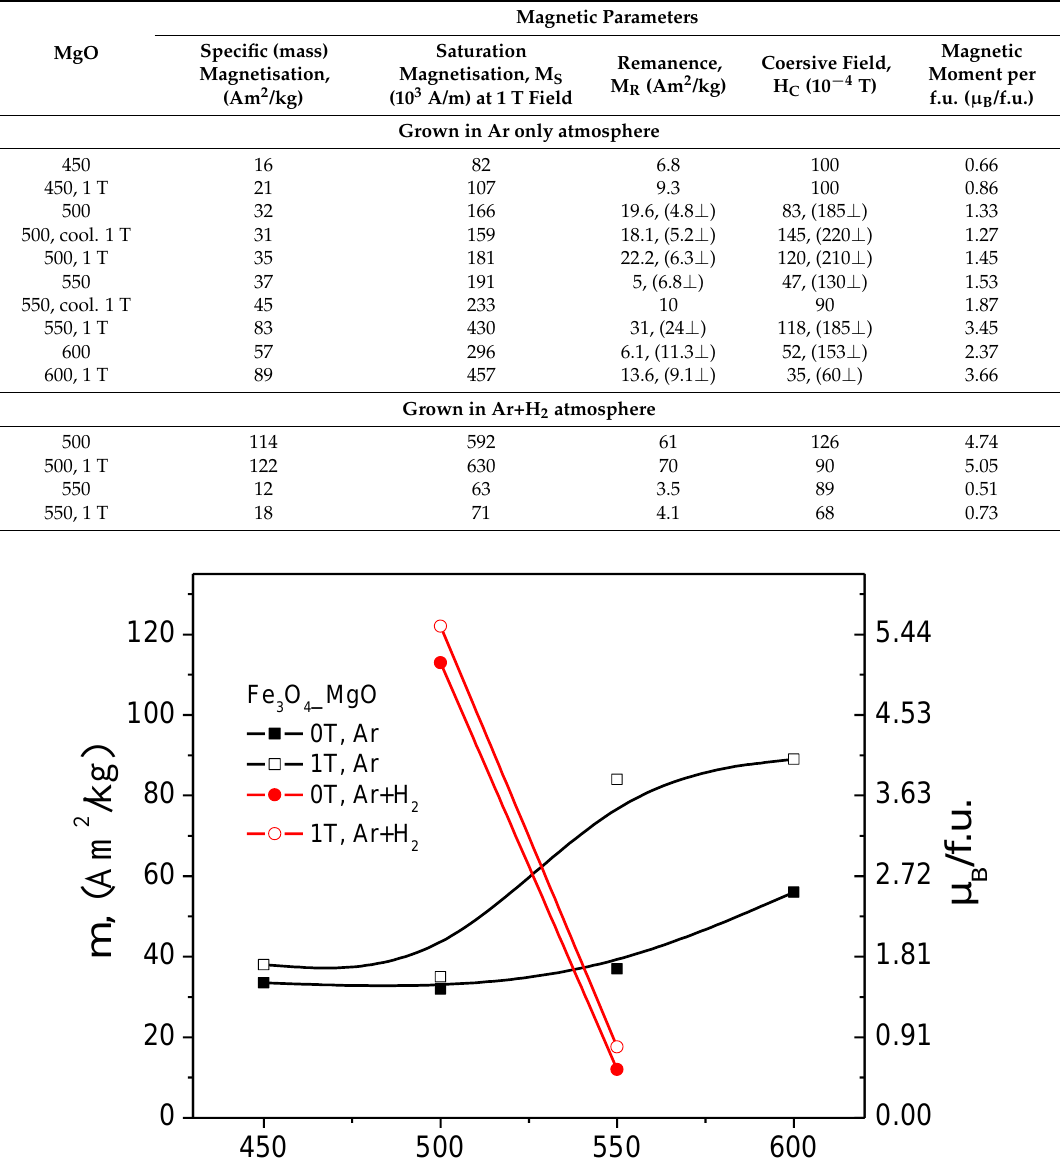
Table 3. The magnetic properties of Fe 3 O 4 films grown on MgO at different deposition parameters.